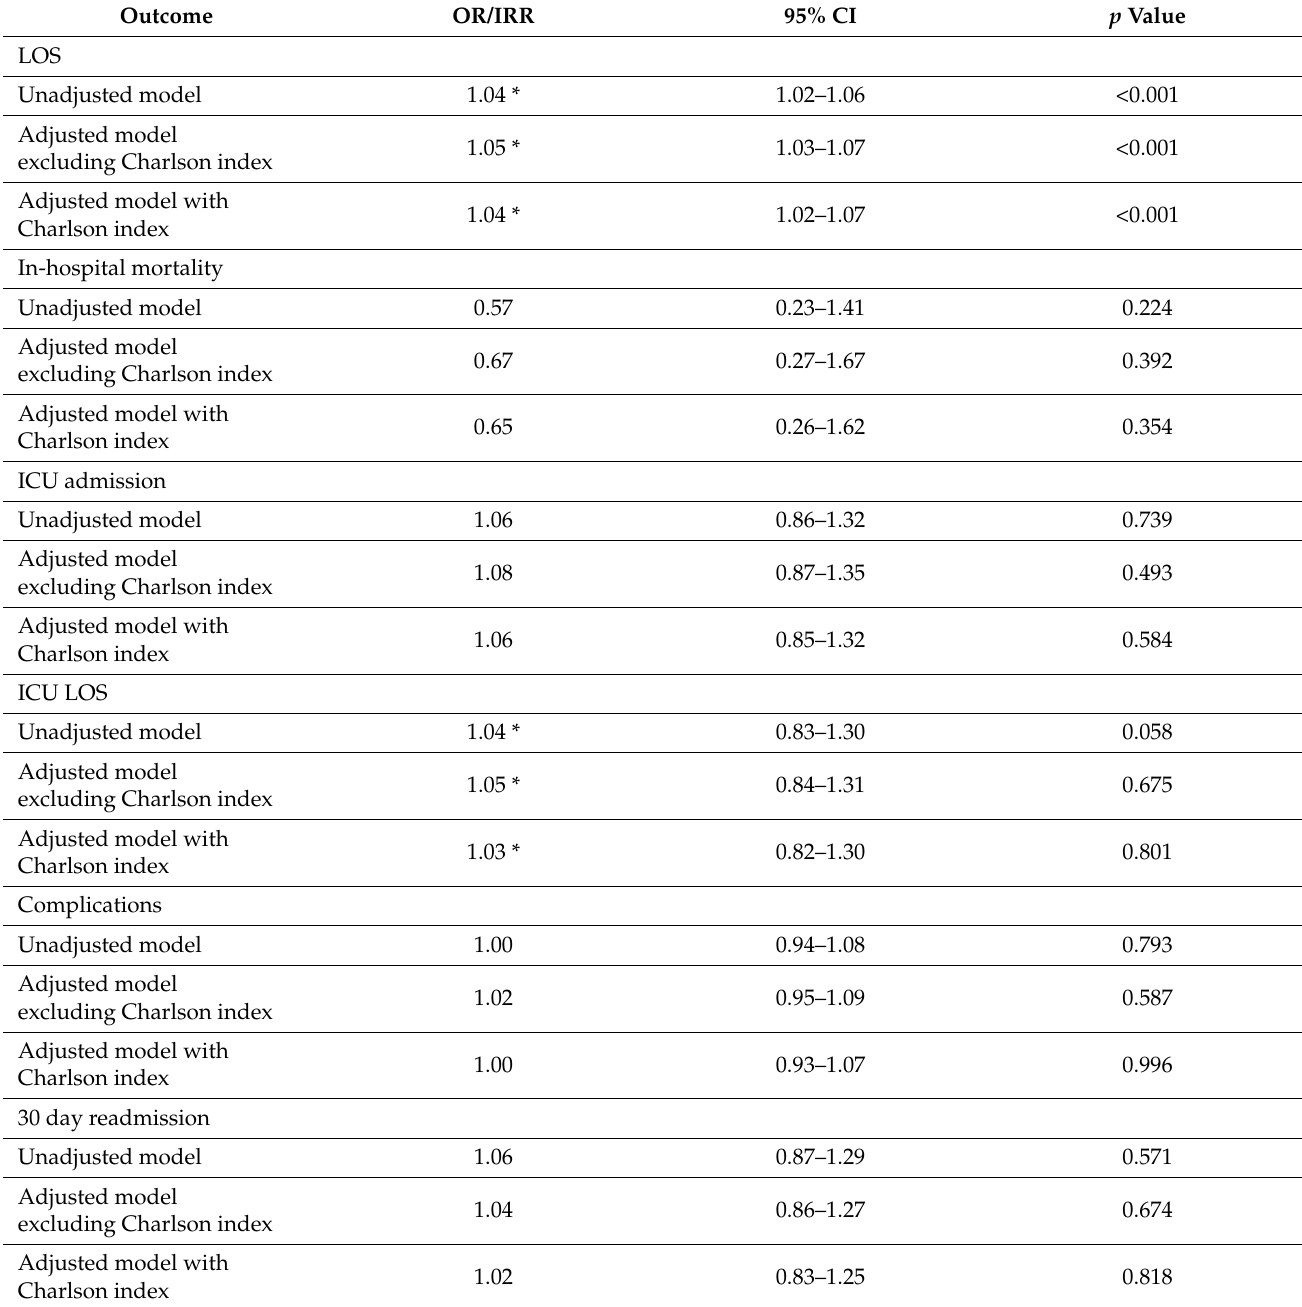
Table 4. Multilevel mixed effects regression models comparing clinical outcomes in morbidly obese with normal/overweight patients.